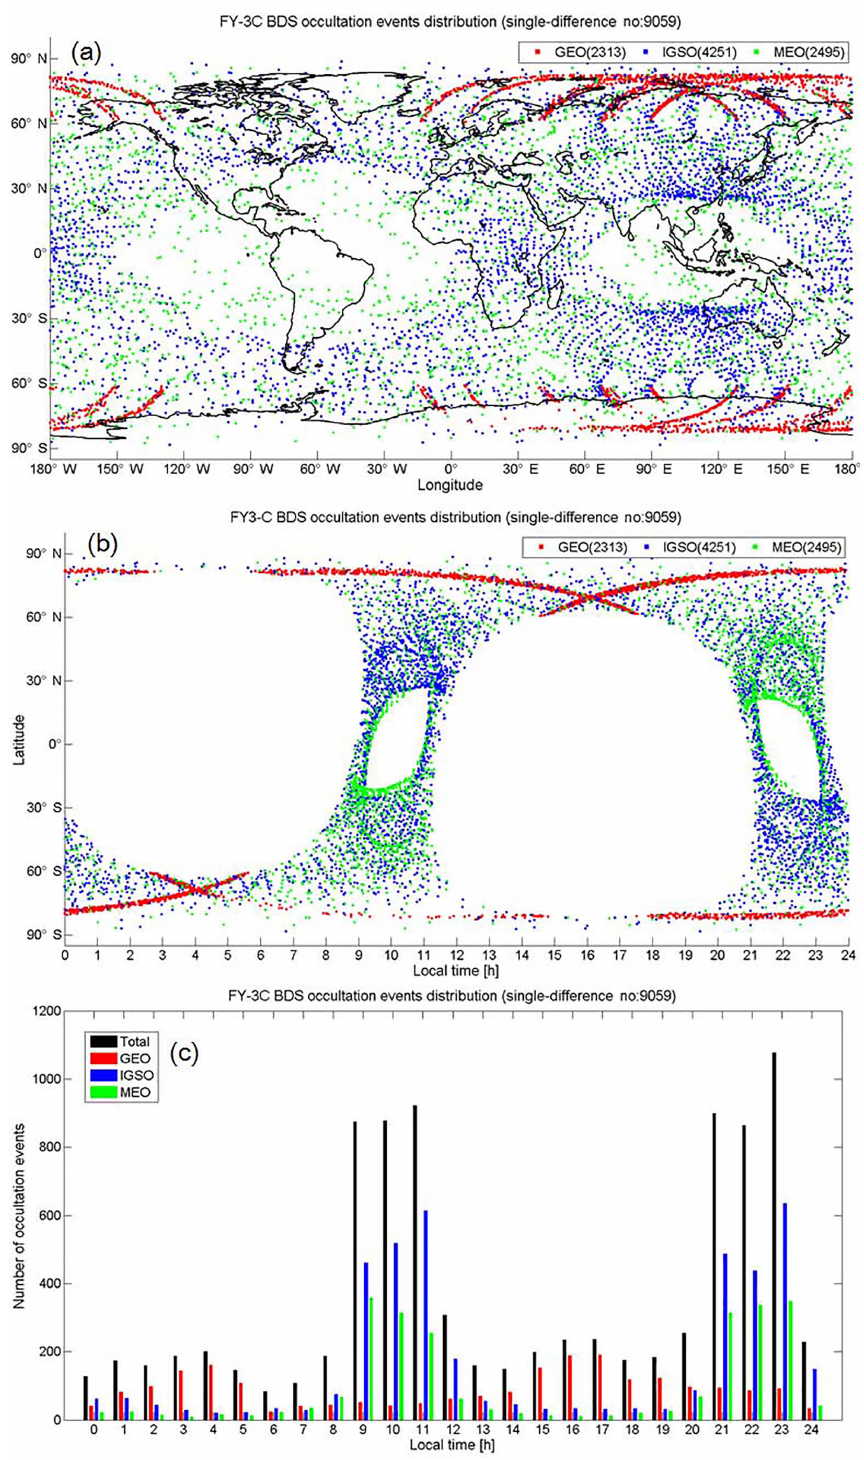
Figure 5. Geographical and local time distribution of the GNOS BDS RO events that have proper BDS reference satellites for single- difference processing (red from the BDS-GEO satellites; blue from BDS-IGSO; green from BDS-MEO; numbers in parentheses denote the associated number of events during October–December 2013). Distributions are shown as a function of latitude and longitude (a) , as a function of local time and latitude (b) , and in histogram style as a function of local time (black denotes from all BDS satellites) (c)